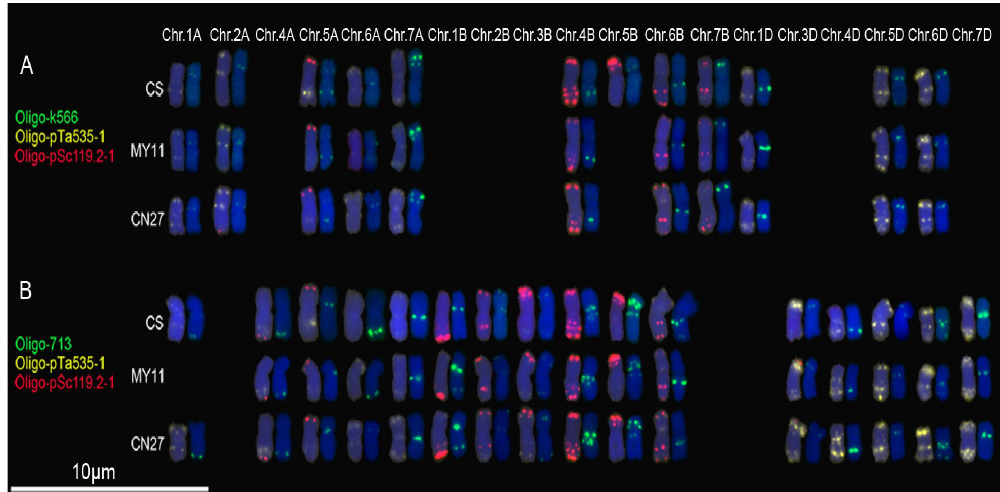
Figure 4. Oligo-k566 ( green ) and Oligo-713 ( green ) combined with Oligo-pTa535-1 ( yellow ) and Oligo-pSc119.2-1 ( red ) were used as probes for ND-FISH analysis of root tip metaphase chromosomes of wheat varieties CS, MY11 and CN27: ( A ) Oligo-k566 hybridization patterns; and ( B ) Oligo-713 hybridization patterns. Only the chromosomes with strong or clear signals of Oligo-k566 or Oligo-713 were cut and pasted. Chr.: chromosome. Chromosomes were counterstained with DAPI ( blue ).